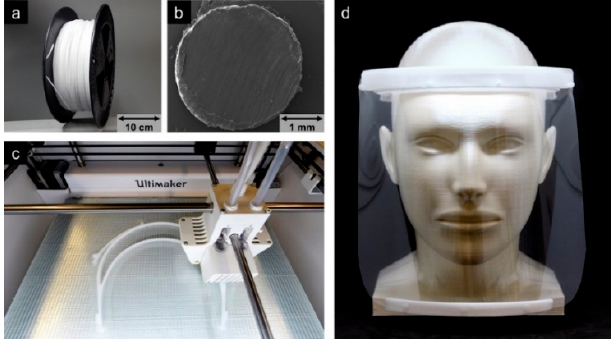
Figure 3. Extruded polypropylene (PP) filament on a spool ( a ) and SEM image of the cross-sectional area of the filament ( b ) applied for 3D printing of sterilizable and reusable headbands for face shields ( c , d ) during the COVID-19 pandemic for use as protective equipment at the medical center Freiburg, Germany, manufactured from a PP with certified biocompatibility (USP class VI).